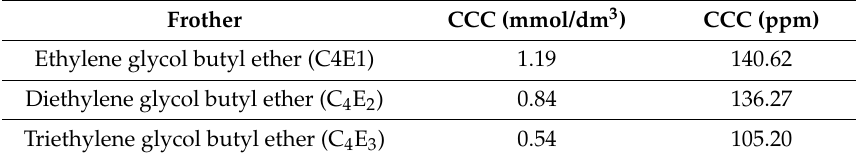
Figure 3. Graphical determination of the CCC values for C 4 E 1 , C 4 E 2, and C 4 E 3 . Table 3. Critical coalescence concentration (CCC) values for the investigated frothers.